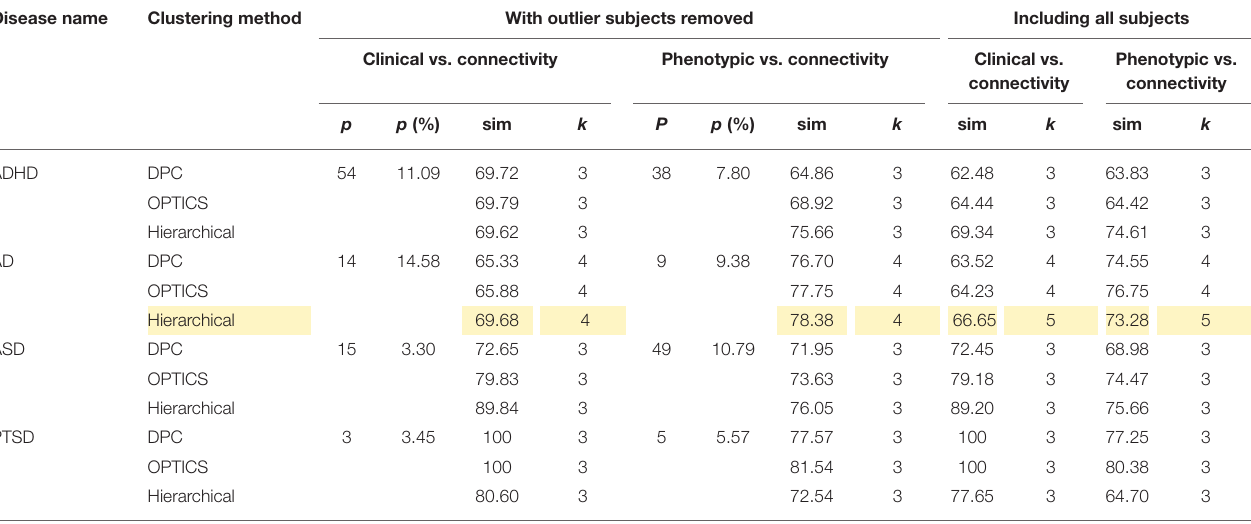
TABLE 14 | Comparison of peak similarity obtained with and without elimination of outlier subjects. Disease